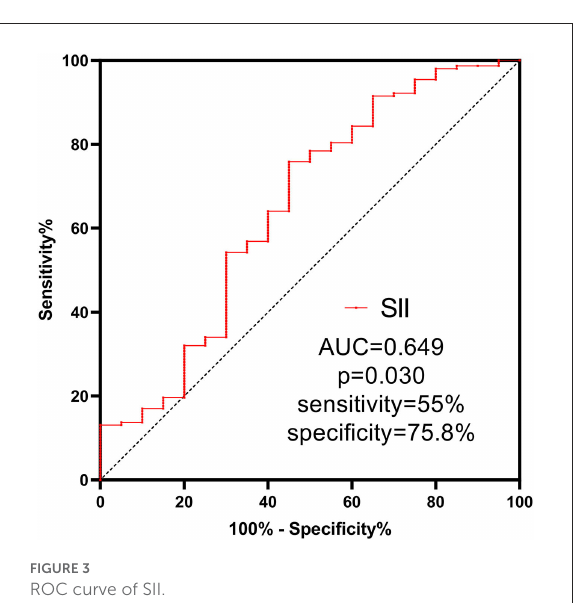
the training set ( n = 126) and validation set ( n = 43). Age, sex, SII, serum potassium, responsible artery, and PT were included in the binary logistic regression and the nomogram model was developed based on the regression equation (Figure 4). With the exception of age, which was a continuous variable, other